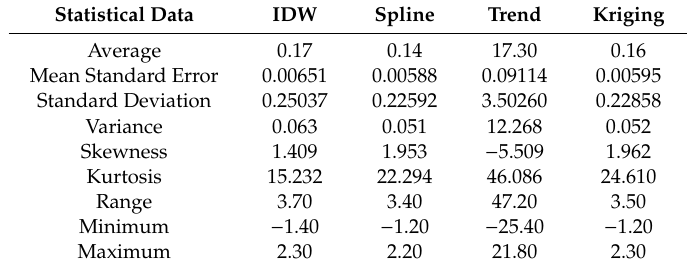
Table 4. The statistical table of the errors.